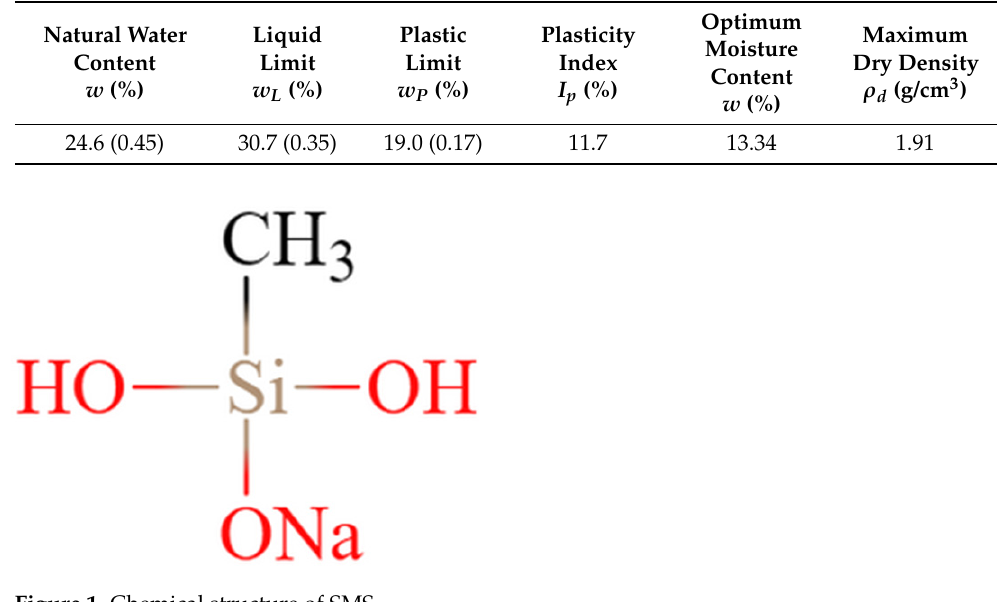
Figure 1. Chemical structure of SMS.